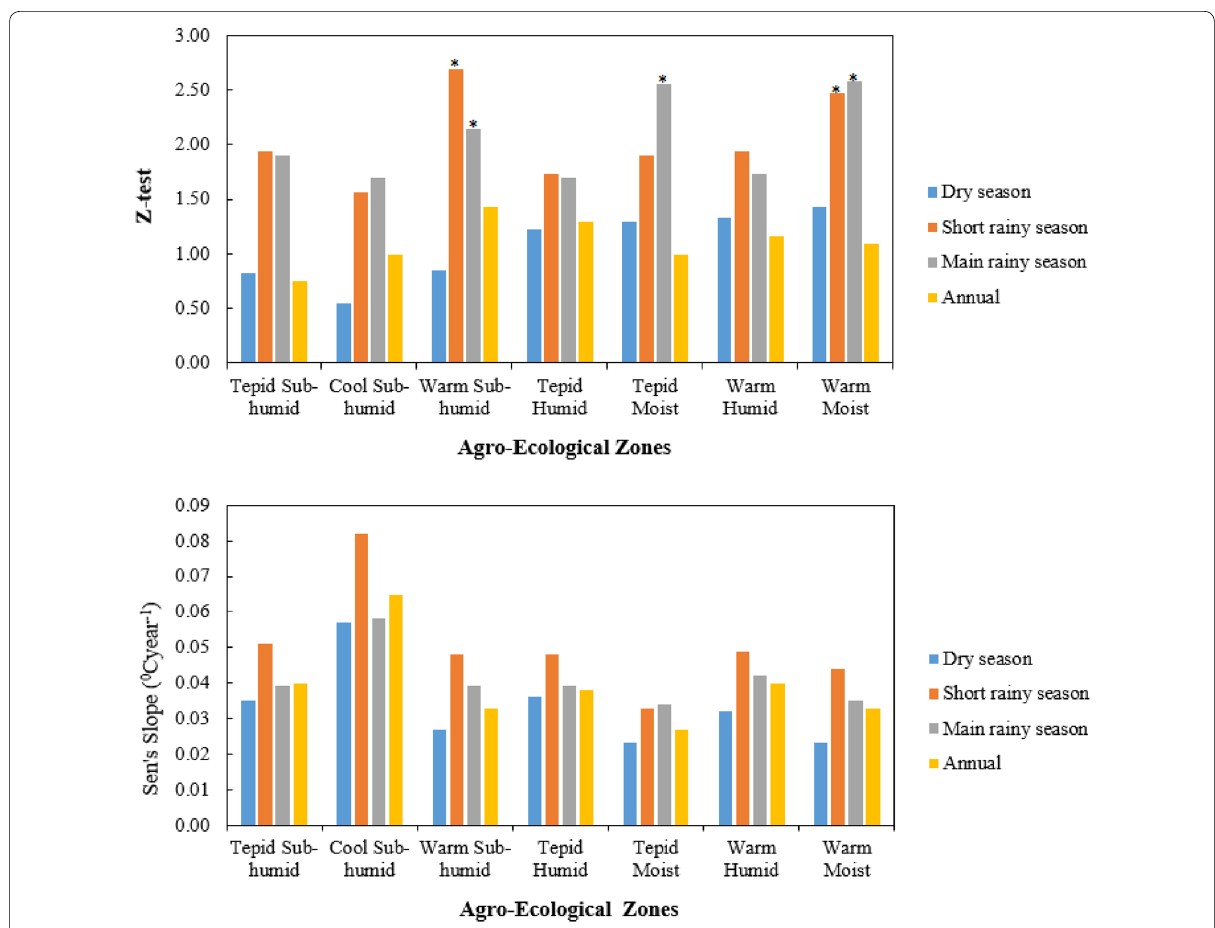
Fig. 3 Z-test (top) and Son’s slope (bottom) of maximum